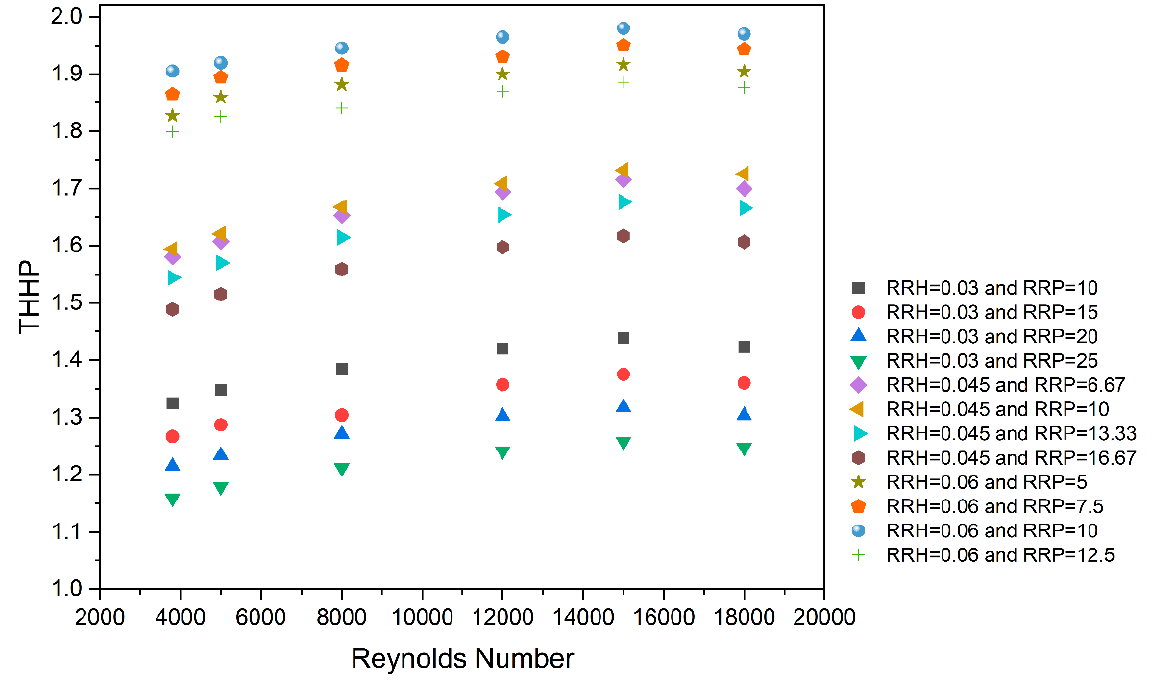
Figure 18. Variation in THPP with Re for different RRH and RRP values.